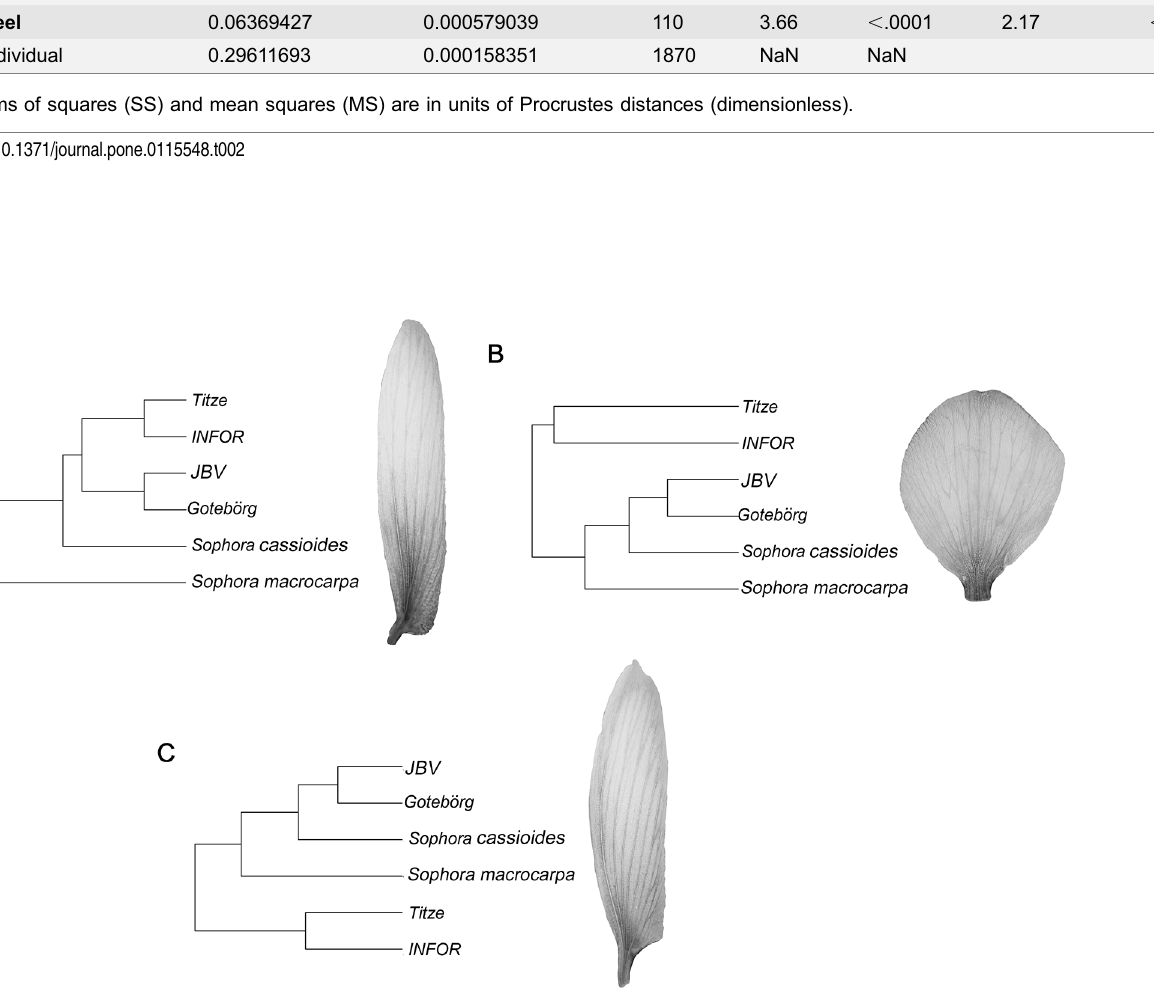
Fig. 5. UPGMA of the procrustes distances between the average shapes of the different lines: a) wing, b) standard and c)